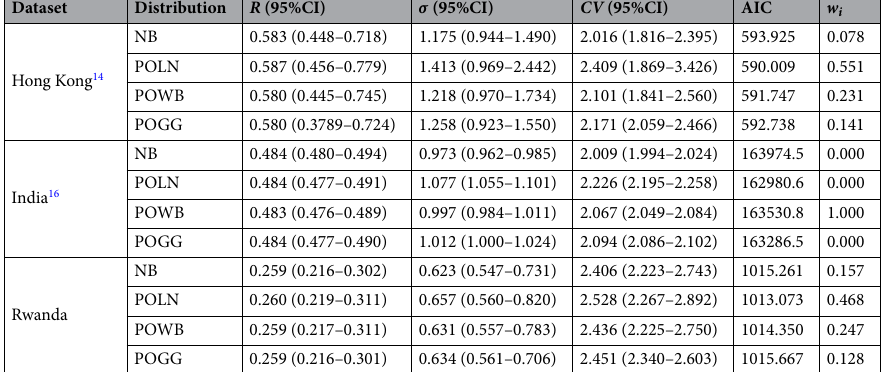
Table 1. Estimates of the offspring mean R and its standard deviation ( σ ), in addition to the coefficient of variation ( CV ), using the different mixture distributions, and their AIC value and corresponding Akaike weights ( w i ), for three COVID-19 datasets.